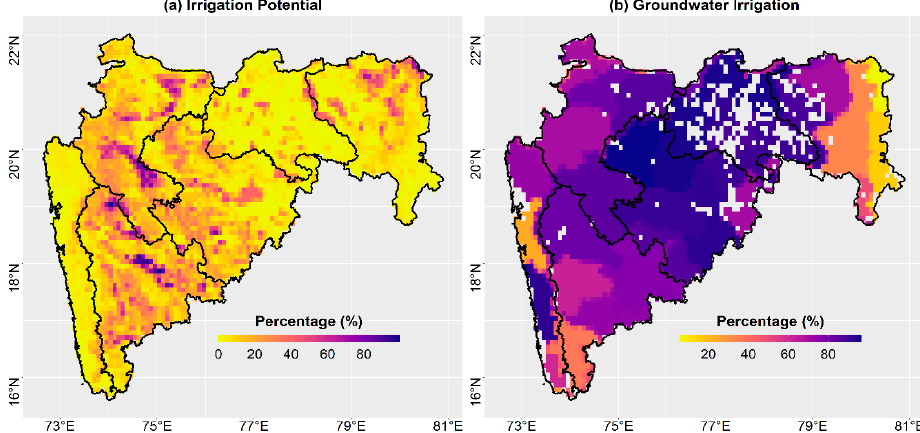
Figure 7. Irrigation data obtained from GMIA-FAO. ( a ) Area equipped for irrigation as a percentage of the total area of the cell (AEI) showing irrigation potential, and ( b ) Area irrigated by groundwater (AEI_GW) expressed as a percentage of AEI (white colored area represents No-data pixels). AEI includes both surface and GW irrigation; water extracted from wells, tube-wells, boreholes, or springs is considered groundwater, and water extracted from rivers, reservoirs, lakes, streams, dams, canals, ponds, or tanks is considered surface water.